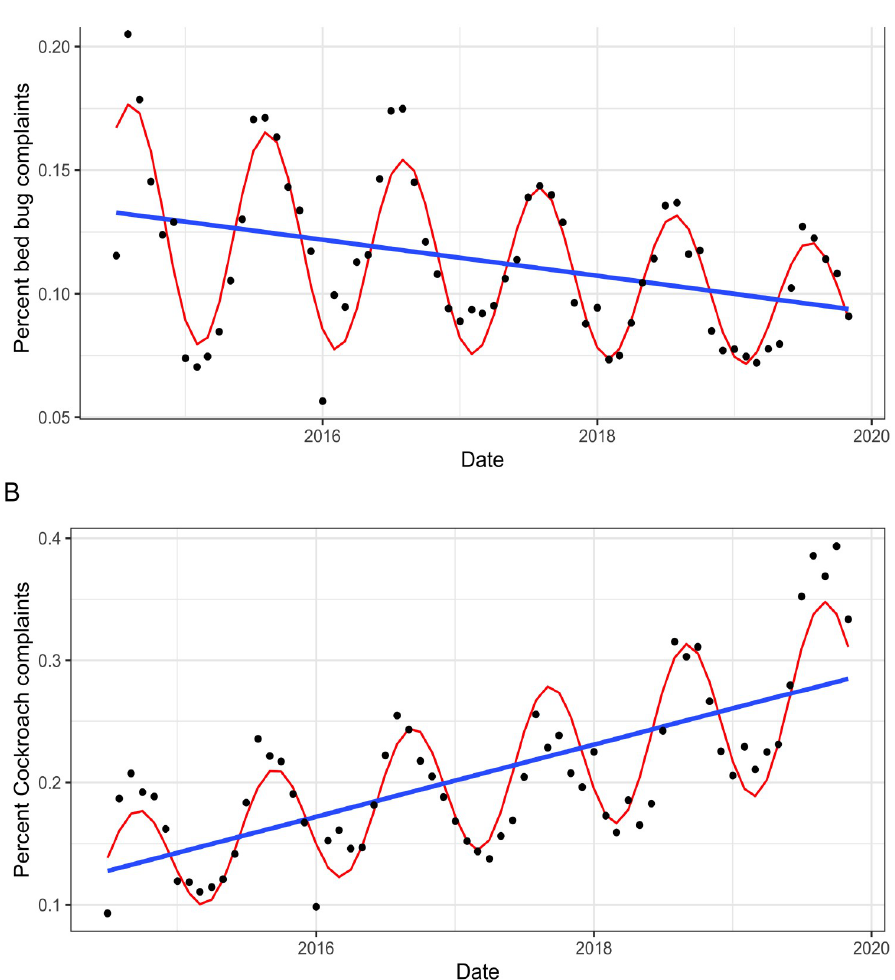
Fig 2. Longitudinal analysis of official bed bug and cockroach complaints registered to HPD. Graphical representation of the results of a linear harmonic model assessing the temporal relationship of official bed bug and cockroach complaints from 2014–2019. ( A ) Bed bug complaints modeled as a linear harmonic model with decreasing amplitude over time. ( B ) Cockroach complaints modeled as a linear harmonic model with increasing amplitude over